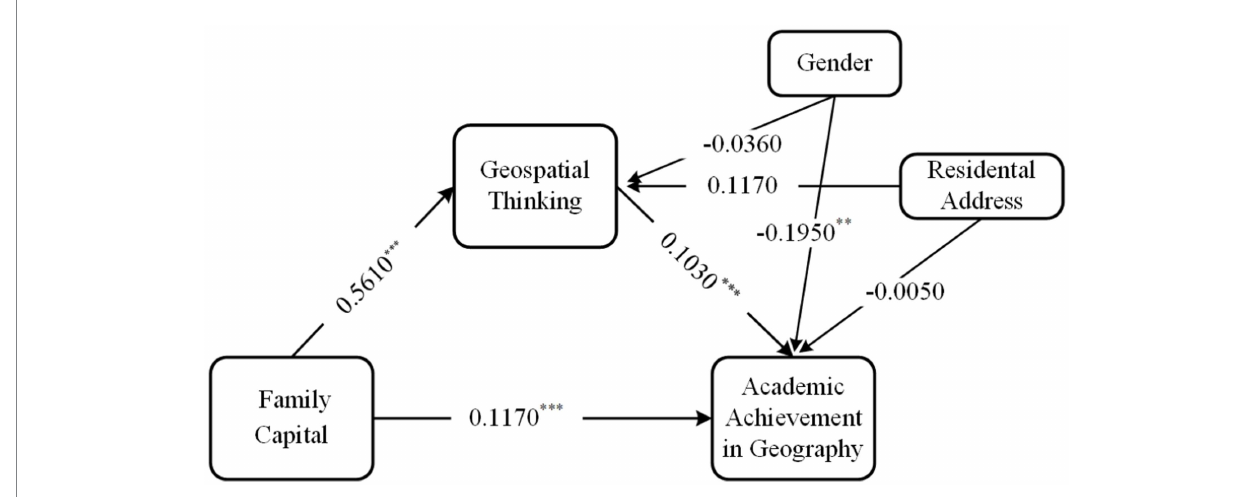
FIGURE 2 The mediation model showing relationships between Family Capital and Academic Achievement in Geography and the mediating role of Geospatial